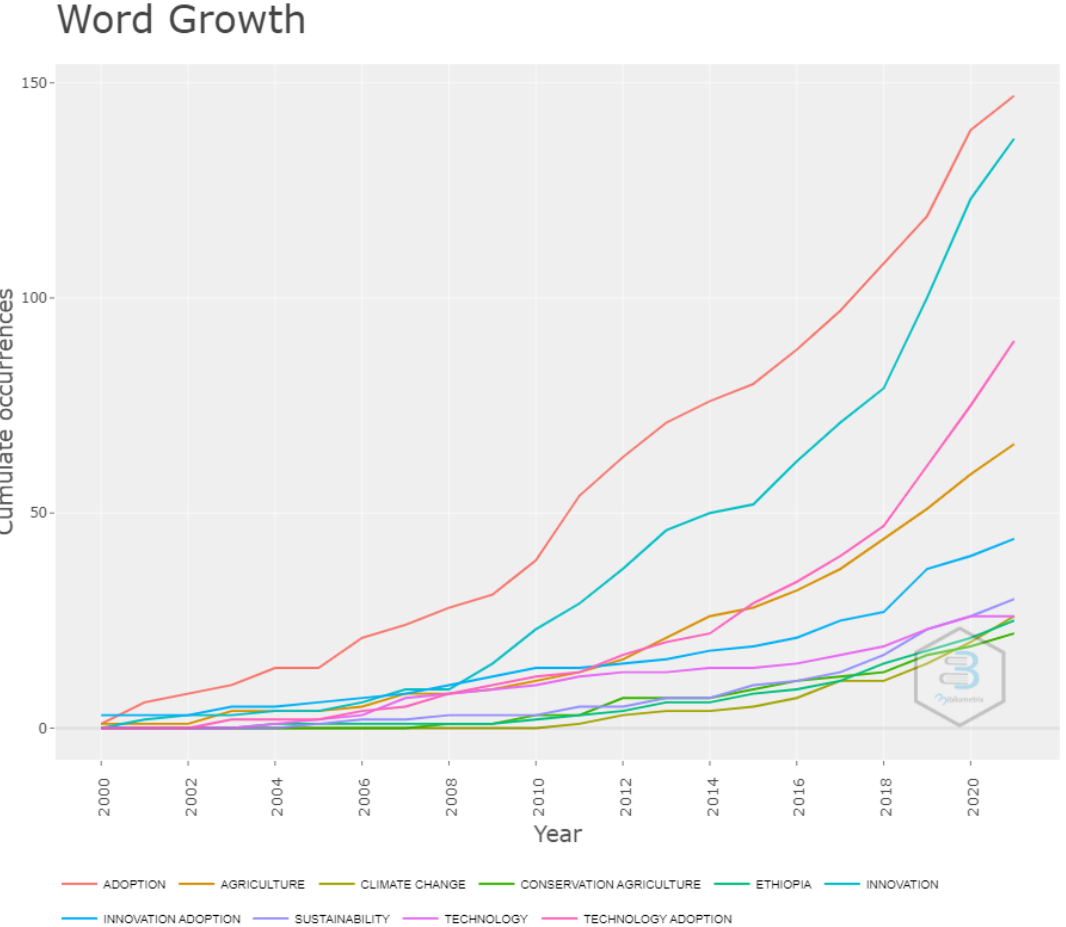
Figure 3. Dynamics of the conceptual structure growth in the period under review (2000–2020). Note: The figure was generated using R Studio software (Bibliometrix tool) with the bibliographic coupling method [53], analyzing keywords, i.e., terms obtained from the title, abstract, or docu- ment ’ s body, previously extracted as data from WoS and Scopus online databases.